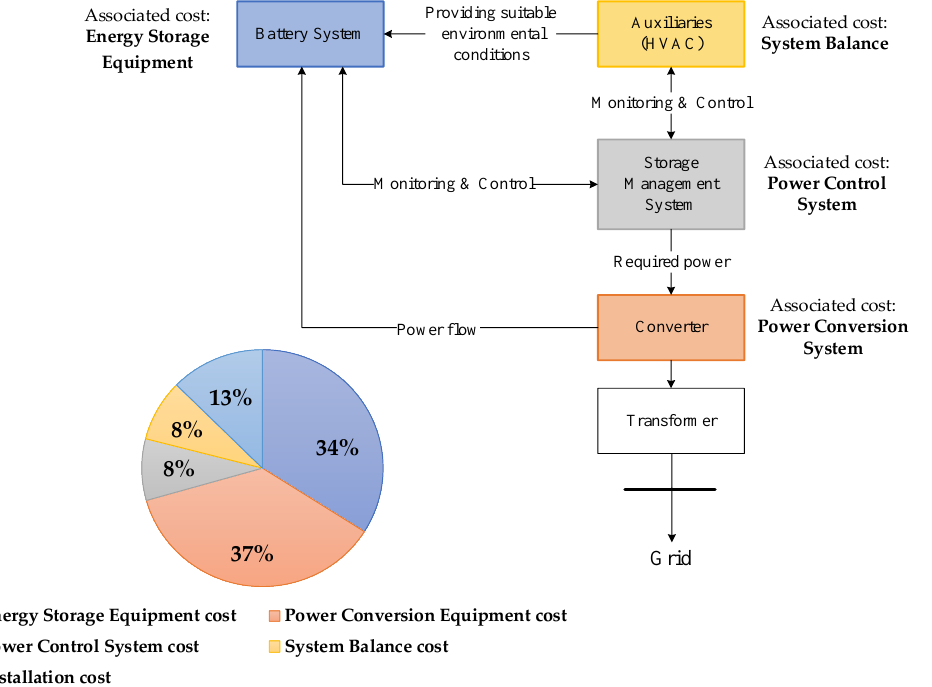
Figure 6. Schematics of BESS and distribution of associated capital costs categories.